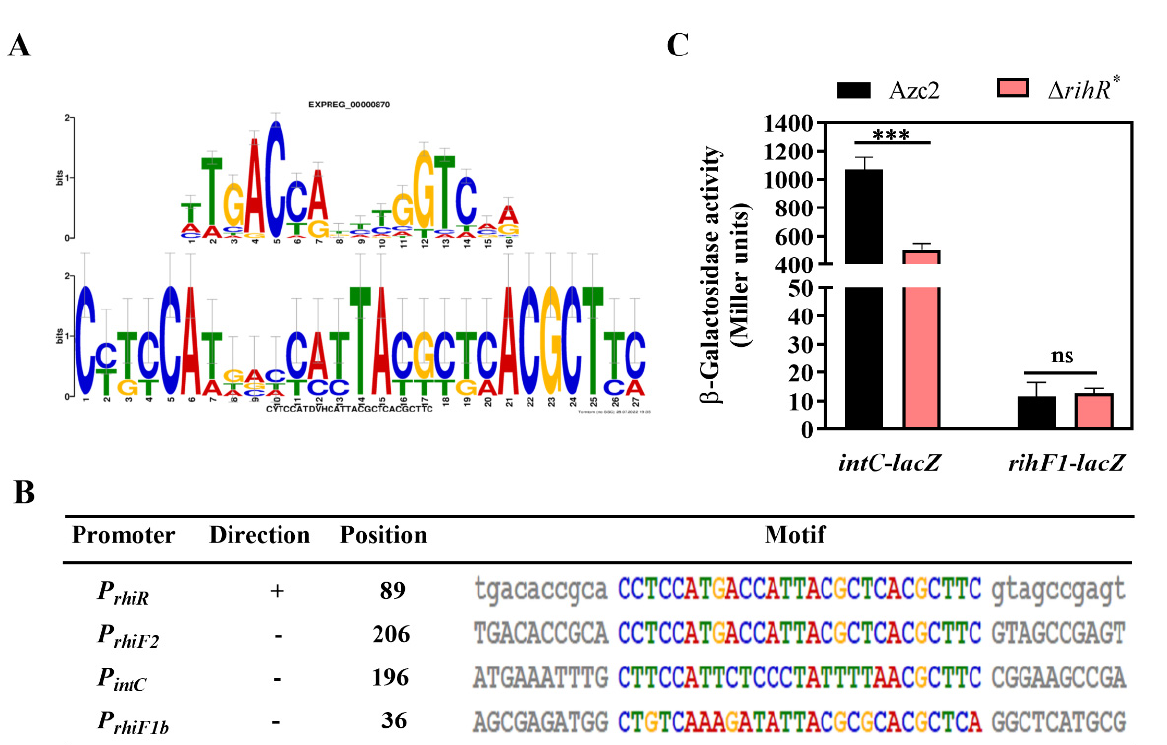
Figure 4. RihR positively regulates intC expression in vivo. ( A ) The promoter motif was predicted by MEME in rgf4 genes and intC . Top: The motif results from a comparison with a known motif database by using the Tomtom program. Bottom: The motif is predicted based on the intC , rihR , rihF2 , rihF1a , and rihF1b promoters. ( B ) The specific positions of the predicted motif in different promoters. +: The motif site was found in the sequence as it was supplied. − : The motif site is found in the reverse complement of the supplied sequence. ( C ) β -galactosidase activities of the transcriptional fusion rihF1 - lacZ and the translational fusion intC - lacZ were measured in Azc2 and ∆ rihR *. Data are mean ± SD of three independent experiments. ***: Student’s t -test p < 0.001, ns: no significant difference.